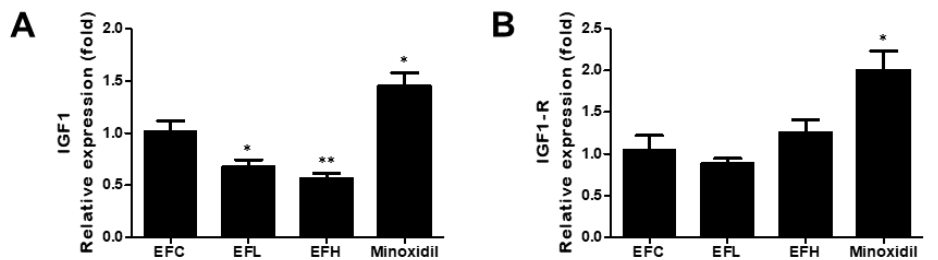
Figure 7. The effect of EF-2001 on the mRNA expression of hair-growth-related genes ( A ) IGF1 and ( B ) IGF1-R in C57BL/6 male mice. Quantitative PCR analysis of the mRNA expression of IGF1 and IGF1-R in the EFC-, EFL-, EFH-, and minoxidil-treated groups. * p < 0.05, ** p < 0.01 versus EFC. Data are expressed as mean ± SD ( n = 5).